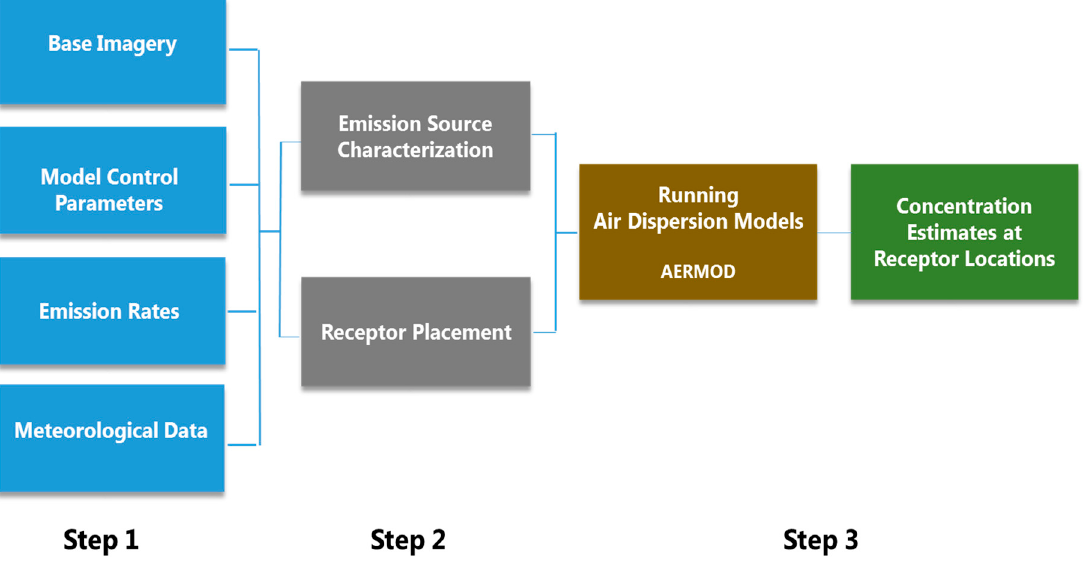
Figure 2. Air dispersion modeling process.